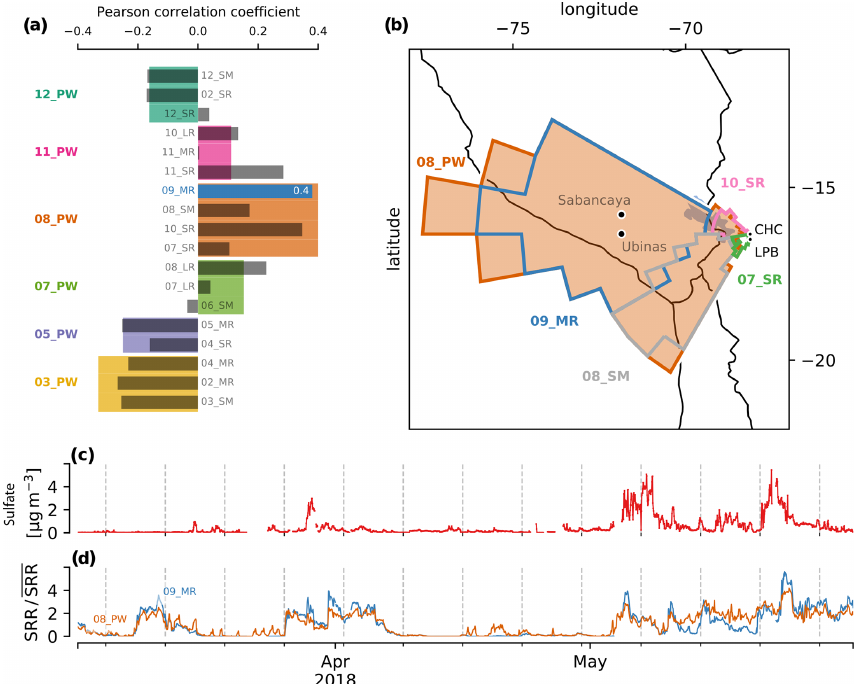
Figure 14. In (a) , we show the Pearson correlation coefficient between sulfate concentrations sampled at CHC and both the 18 clusters and the 6 PWs. In (b) , the regions covered by the pathway 08_PW and the clusters 09_MR, 08_SM, 10_SR and 07_SR are shown along with Sabancaya and Ubinas volcanoes (both are located within 09_MR). All of the aforementioned clusters are contained by 08_PW. Panels (c) and (d) show the time series of sulfate sampled at CHC and the normalized SRR time series of 08_PW and 09_MR,